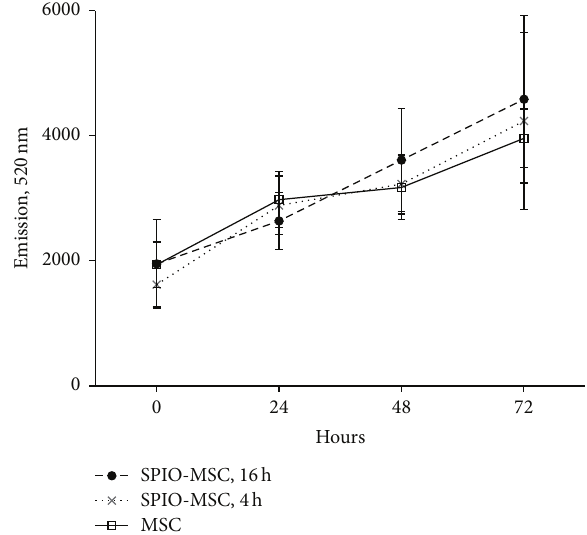
Figure 2: Cell proliferation shown over 72 hours after labeling with SPIOs for 4 or 16 hours as compared with untreated